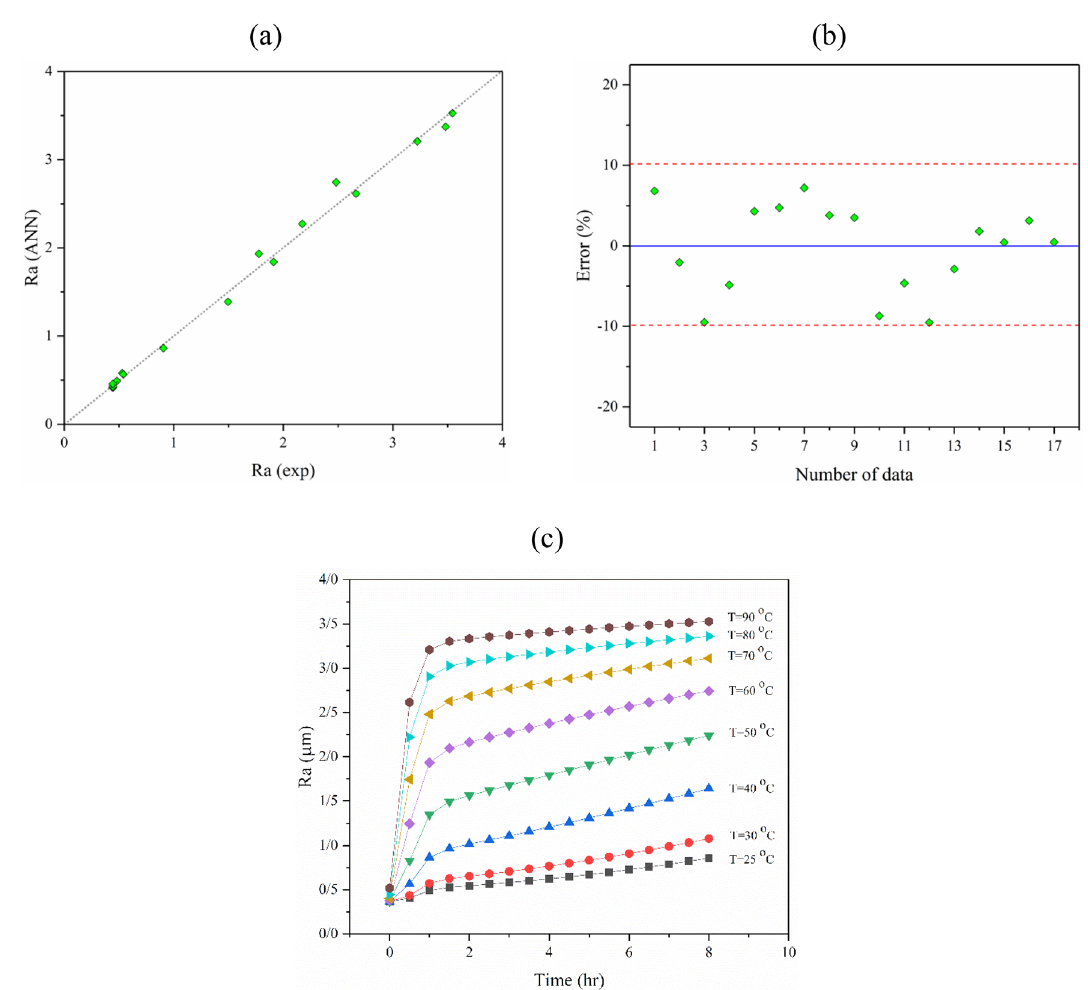
Figure 6. ( a ) Quality line, ( b ) the error values for experimental data and ANN model (R = 0.9892) outputs of